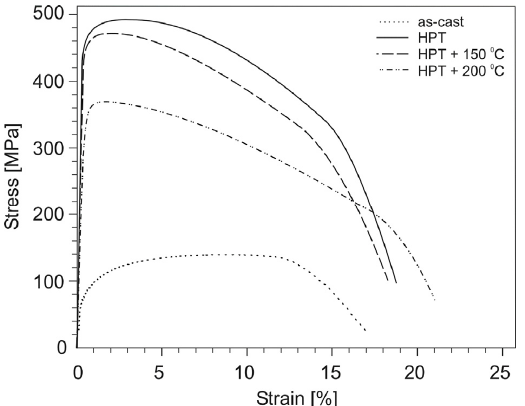
Figure 8. Stress–strain curves for tensile test specimens of the Al–9% Ce alloy in as-cast state, after HPT, and subsequent annealing